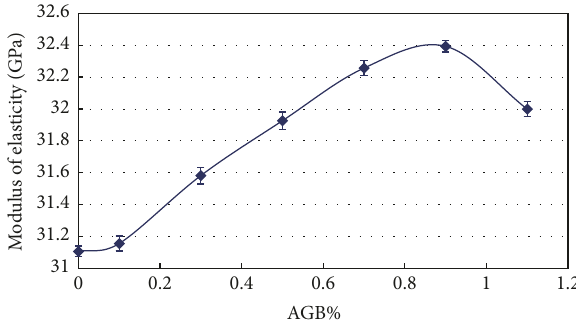
Figure 6: Concrete modulus of elasticity variation with AGB percentage.